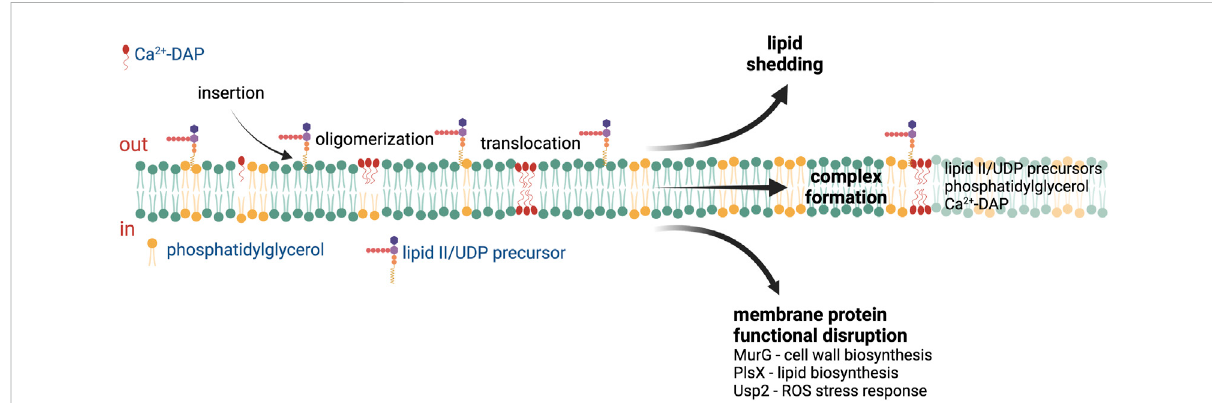
FIGURE 1 Proposedmechanismsofactionofdaptomycin.Afterinsertionintothecellmembrane,theCa 2+ -daptomycincomplexoligomerizeintheouter lea fl et of the cell membrane. Ca 2+ -daptomycin oligomers are translocated to the inner lea fl et of the cell membrane which result in lipid shedding, tripartite formation with phosphatidylglycerol and lipid II/UDP precursors, or membrane protein functional disruption. See text for details. ROS — reactive oxygen species, UDP — undecaprenyl. Figure produced with